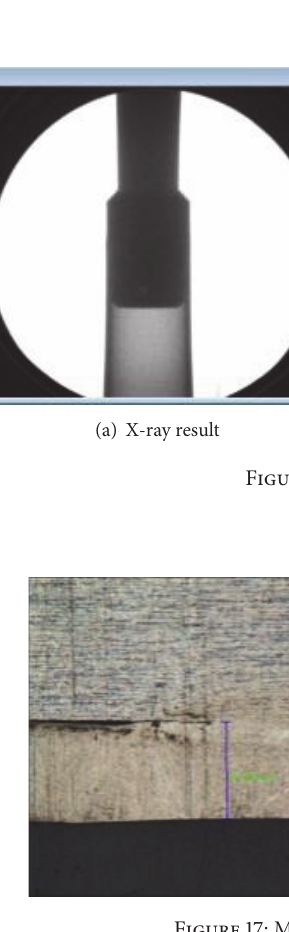
Figure 17: Metallographic examination result on the weld part.